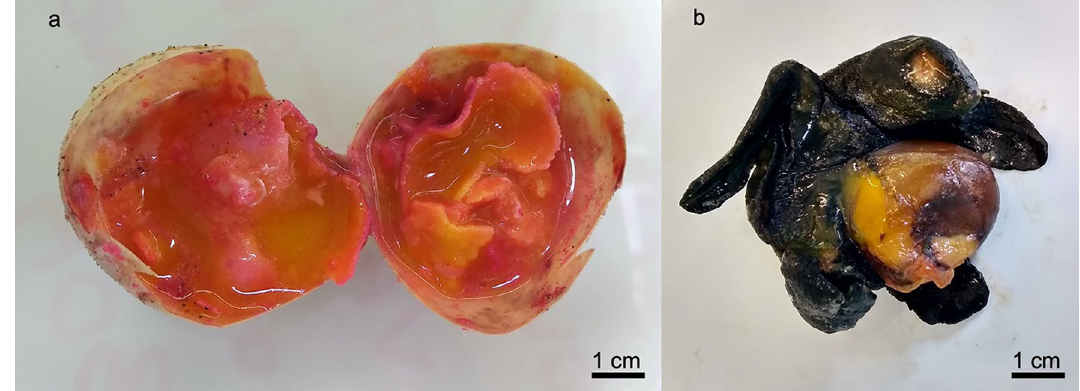
Figure 1. Nest 1 gross appearance. Macroscopical aspect of one unhatched egg ( a ) and one embryo ( b ) with evident signs of F. oxysporum infection. Scale bar = 1 cm.